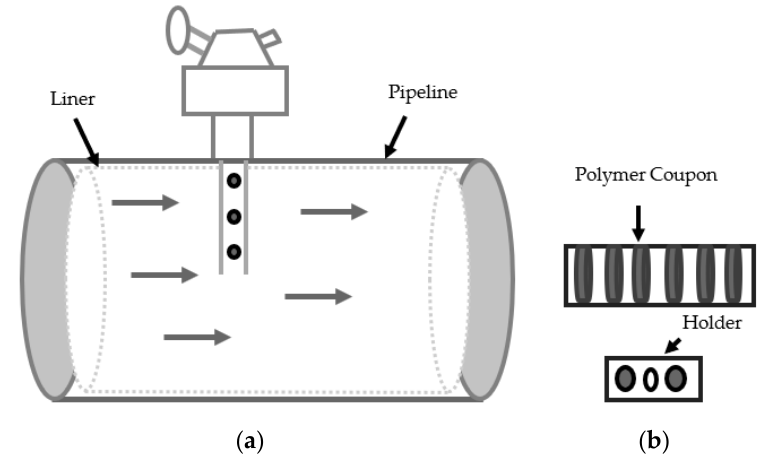
Figure 1. ( a ) Polymer coupon in the pipeline, ( b ) coupon and